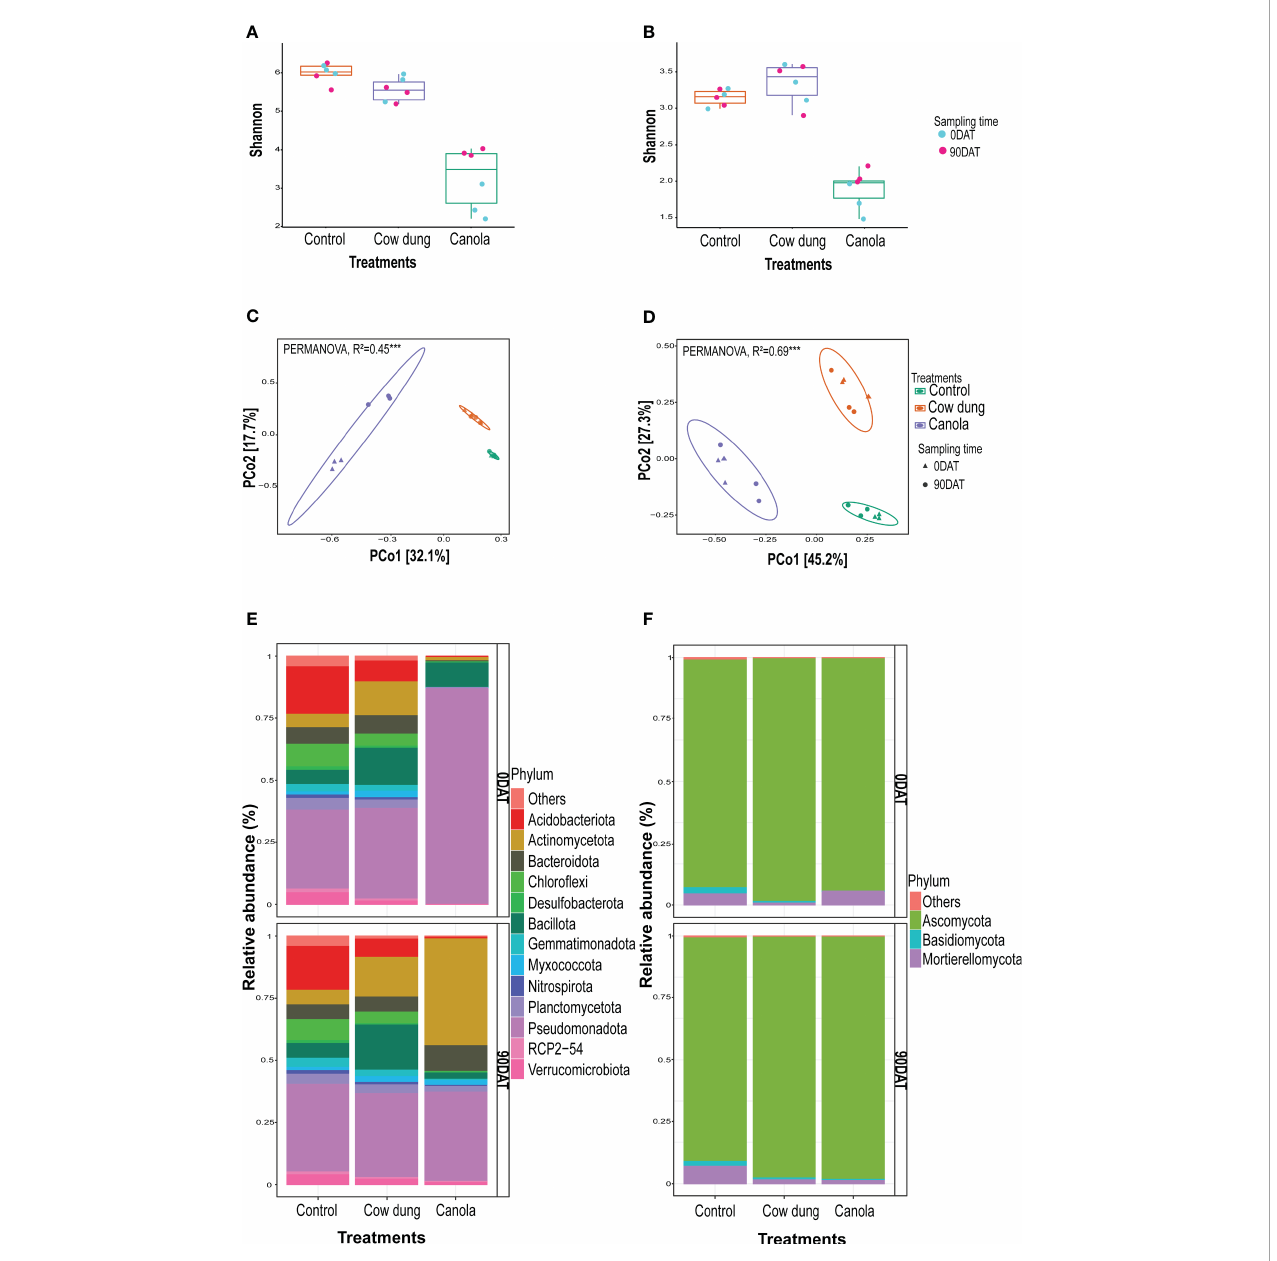
FIGURE 2 Impact of soil amendments on soil microbial diversity and community structure. Alpha bacterial (A) and fungal (B) diversities. Beta diversity of bacteria (C) and fungi (D) showing community structure of the treatments. Bacterial (E) and fungal (F) community composition (>1%) of treatments at phylum level on two sampling